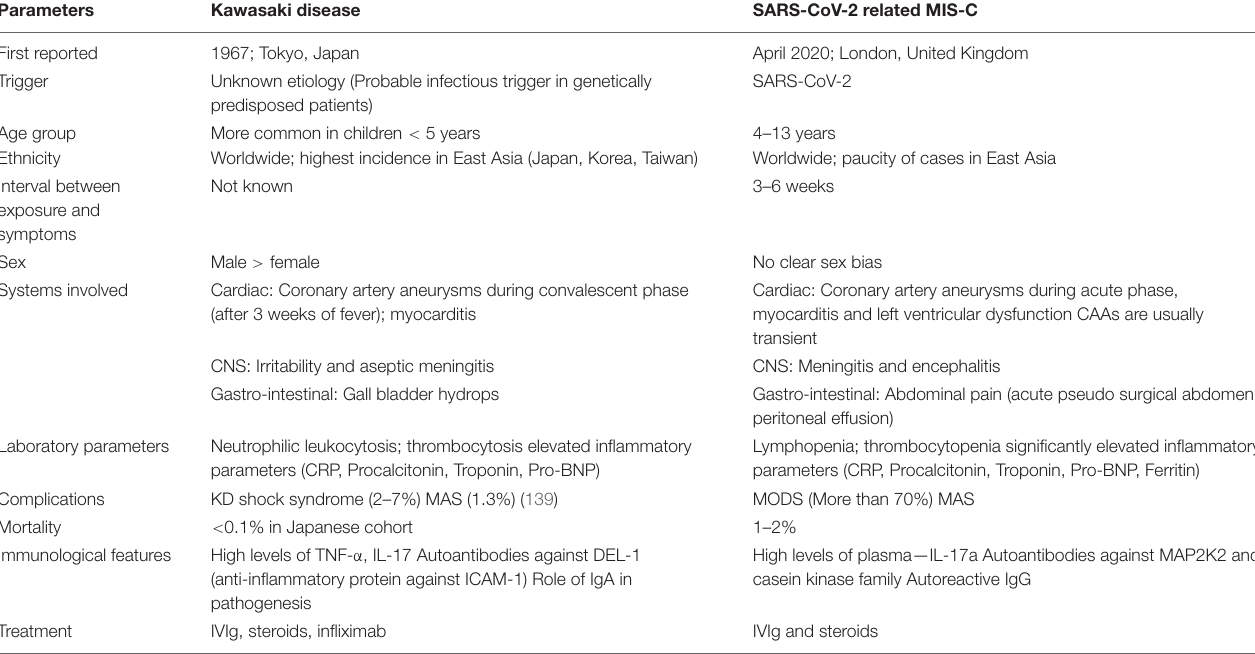
TABLE 2 | Comparison of demographic and clinical features of Kawasaki disease and SARS-CoV-2 related MIS-C.